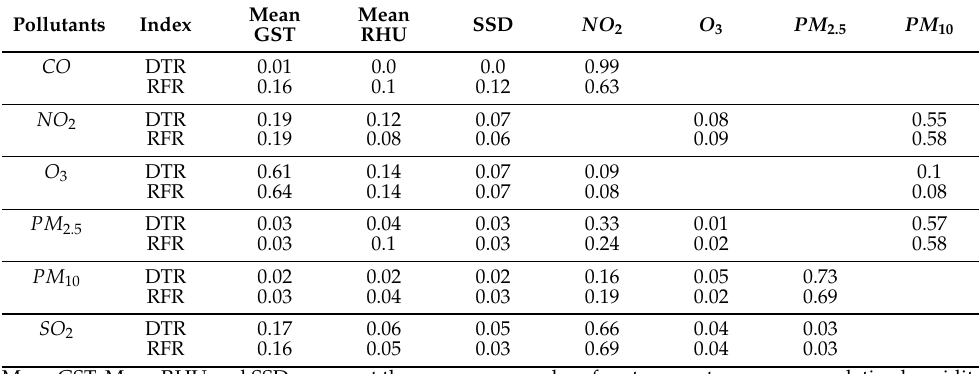
Figure 15. The importance of predictor variables of RFR for ( a ) PM 2.5 and ( b ) PM 10 at Ma Lian Kou. Table 7. The importances of influential factor at Ma Lian Kou in